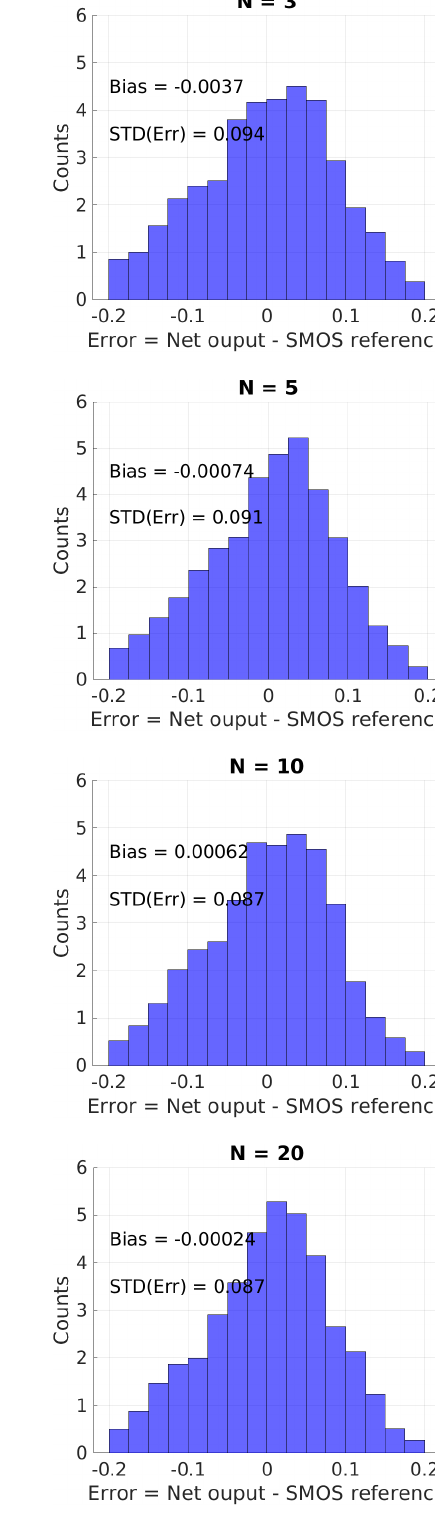
Figure 9. (left) Scatter-density plot and (right) error histogram of the GNSS-R based ANN output with respect to the collocated SMOS SM product from Barcelona Expert Center on Remote Sensing (BEC) [40], showing the four different values of N used to compute the movmean and movstd inputs for the